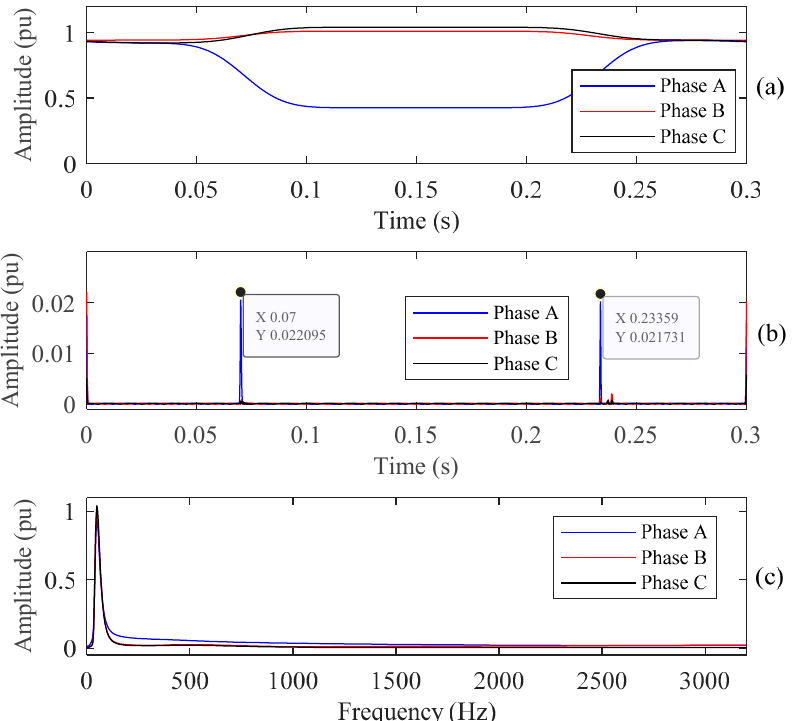
Figure 12. The tested IEEE 13-bus system [41]. Observing the related STA plots at bus node 634 from Figure 13 and comparing with Figure 2, it can conclude that when phase A to ground fault occurs at F.2 the system is bearing a disturbance that